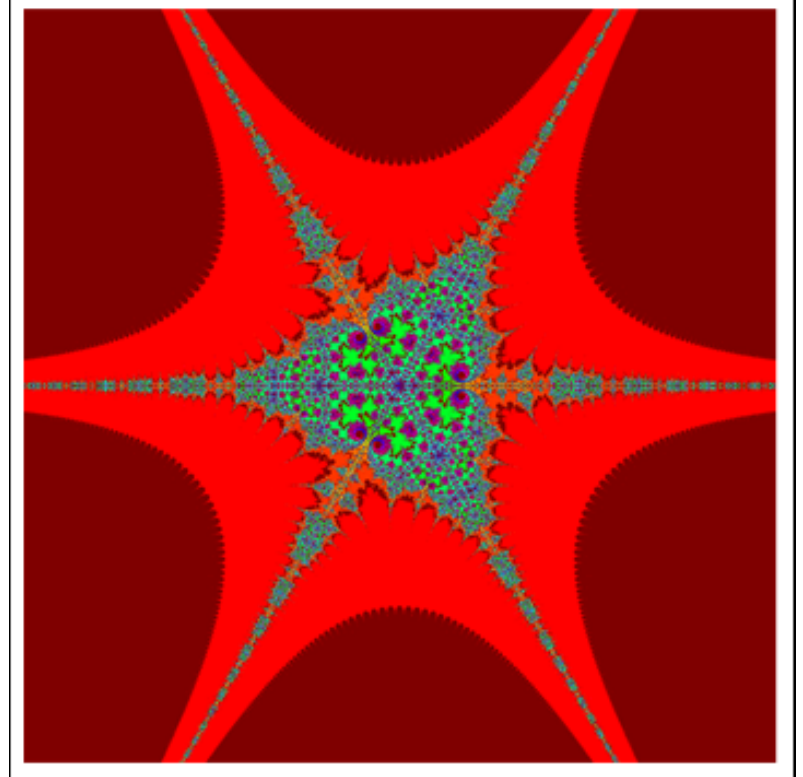
Figure 5. J-set for τ ( z ) = sin ( z 3 ) + c via DKIS. The image execution time is 1017.23